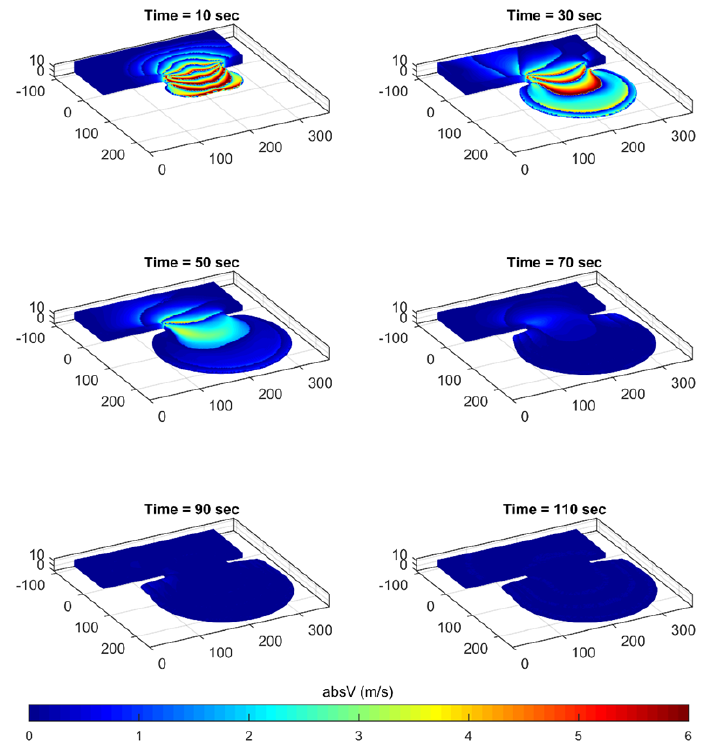
Figure 8. Snapshots of free-surface velocity profiles simulated by BM.